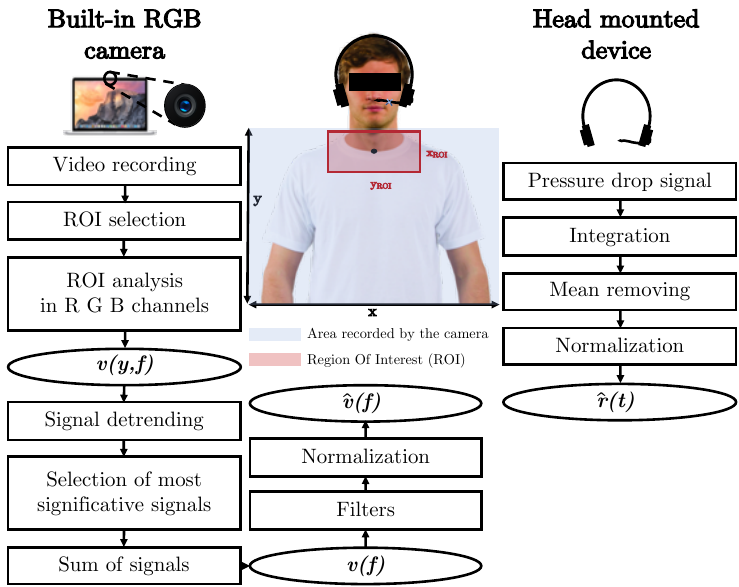
Figure 1. Flowchart presenting all the steps carried out to extract the respiratory pattern from video recorded with the built-in camera (on the left) and from the pressure-drop signal collected at the level of nostrils with the reference device (on the right). Region Of Interest (ROI) is the red rectangle; the area recorded by the camera is highlighted with the blue rectangle, the black point is the pixel (with coordinates x P , y P ) at the level of the jugular